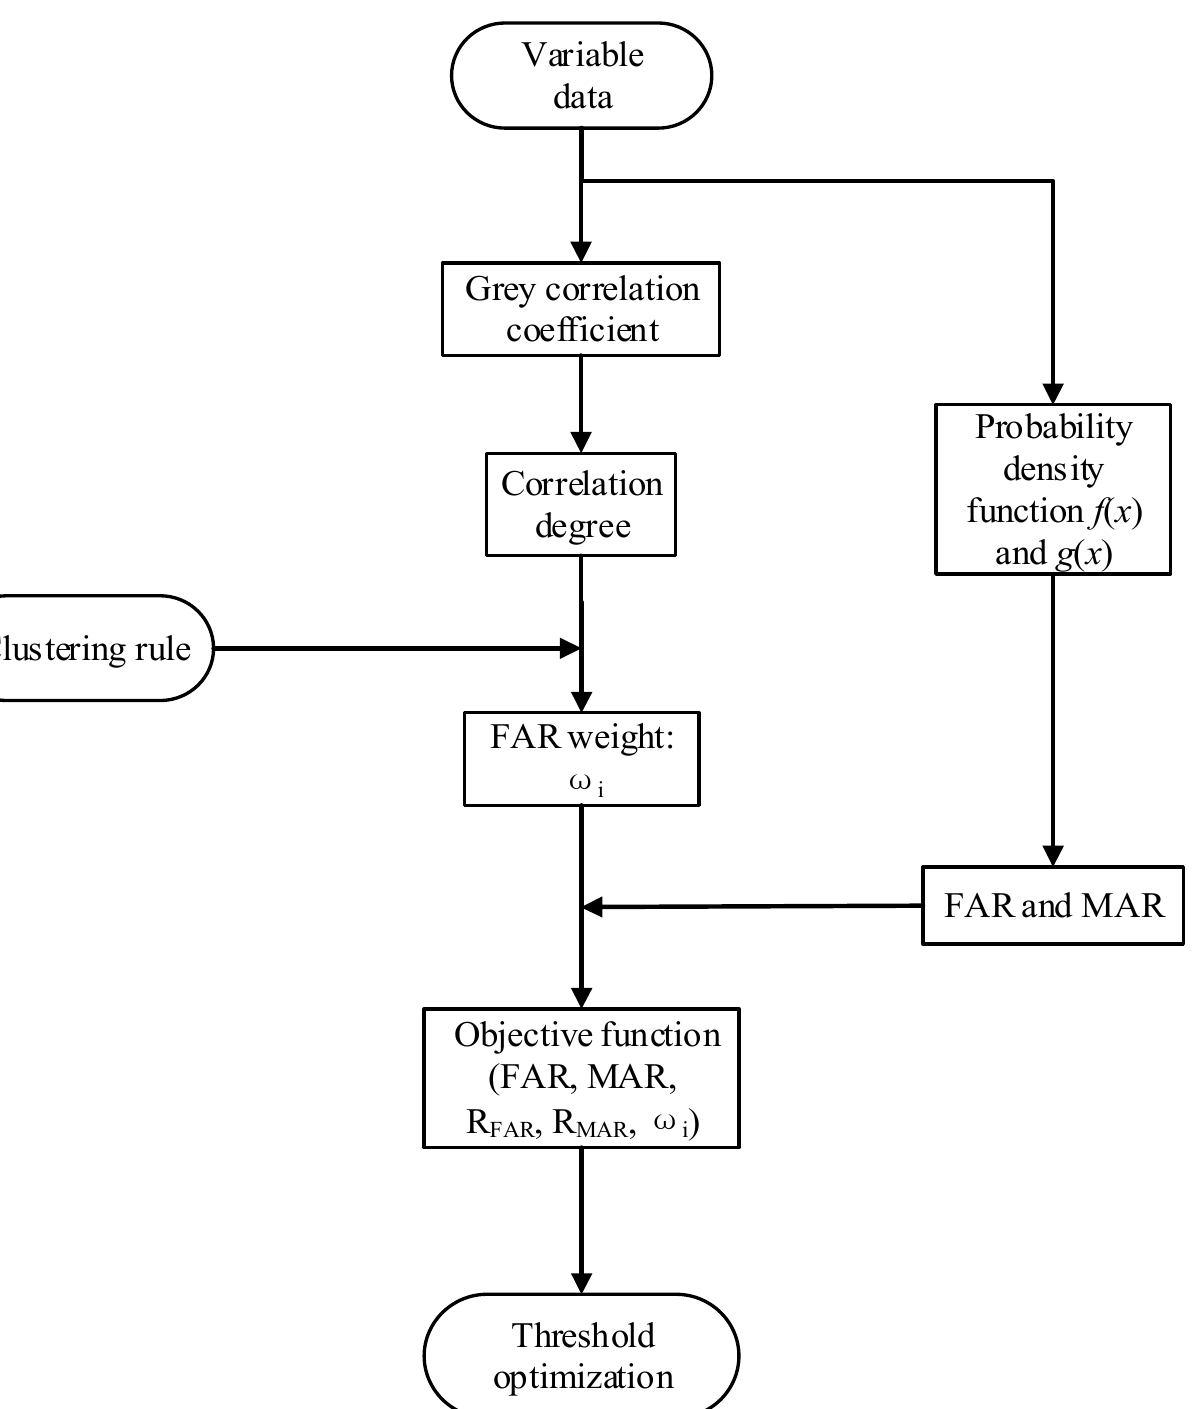
Figure 3. Flow chart of alarm threshold optimization process.